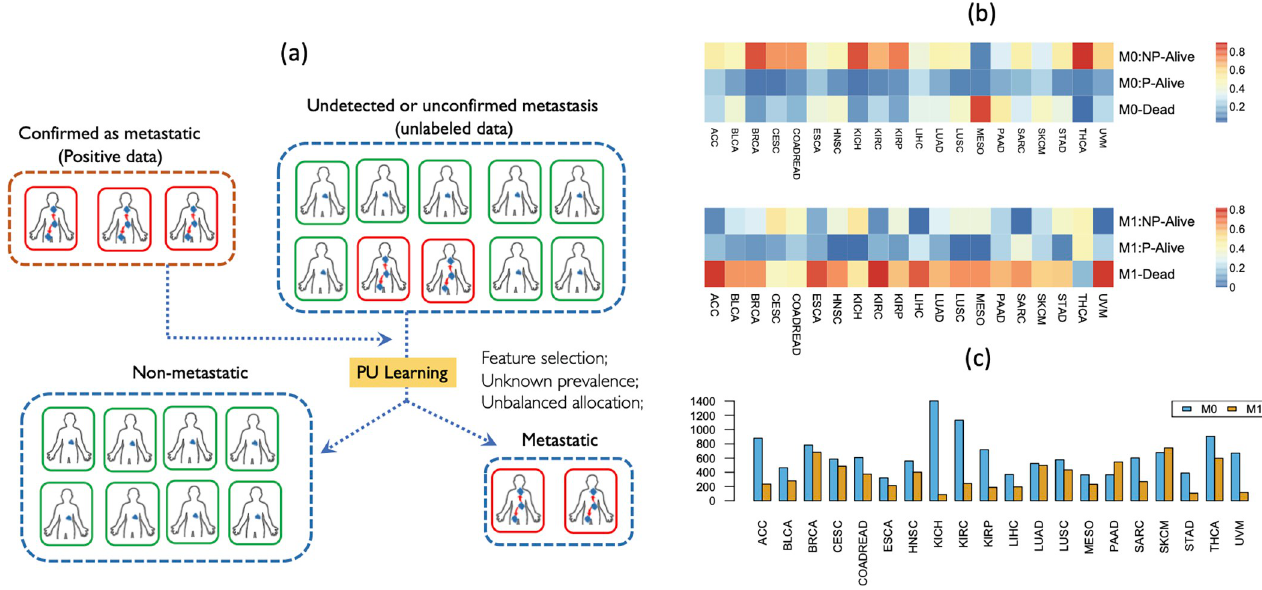
Fig 1. The motivation of PLUS. (a) Under-diagnosis occurred among patients who were not diagnosed as metastatic. To predict the metastasis potential for non-metastatic samples, PLUS builds upon the PU learning framework and is specifically designed to recognize the bias in under-diagnosis, and to address the computational challenges in feature selection, unknown prevalence, and unbalanced allocation. (b) For patients who were clinically diagnosed as non- metastatic (M0) at baseline for each cancer type (columns) in TCGA Pan-Cancer study, the top three rows show the proportions of patients with follow-up information who were found alive and with non-progressed disease (NP-Alive), alive and with progressed disease (P-Alive), and deceased (Deceased). The bottom three rows show the same proportions for patients who were diagnosed as metastatic (M1) at baseline. (c) The median follow-up time ( y -axis) for patients who were diagnosed as non-metastatic (blue) and metastatic (yellow) at baseline for each cancer type ( x -axis).